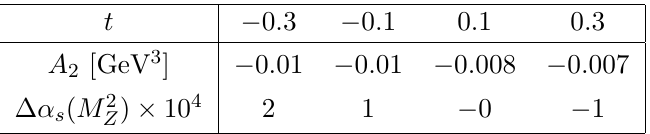
) when the logarithmic correction of eq. (F.1) Z